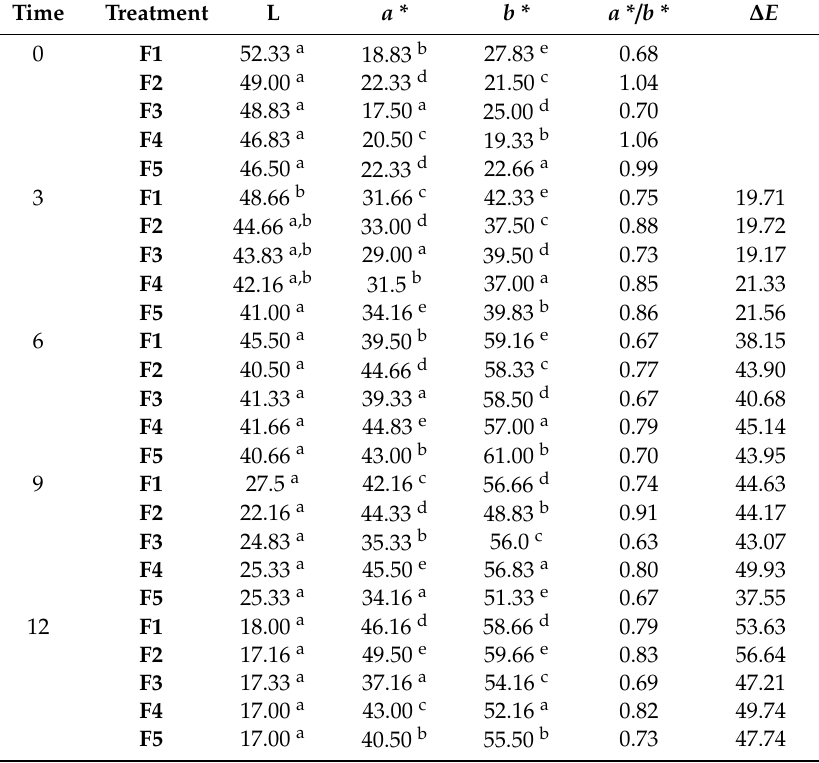
Table 4. The color coordinates L (lightness), a * ( − green, + red), b *( − blue, + yellow), the red − yellow ratio ( a * / b *) and color di ff erence score ( ∆ E ) for tomatoes during the 12 days of storage with the CS + RGEO treatments: F1 = control, F2 = CS, F3 = CS + RGEO 0.5%, F4 = CS + RGEO 1.0%, and F5 = CS + RGEO 1.5%. The superscript letter (a–e) refers to the significant di ff erences ( p < 0.05) of LSD 95% according to the ANOVA test between each treatment in the same column.